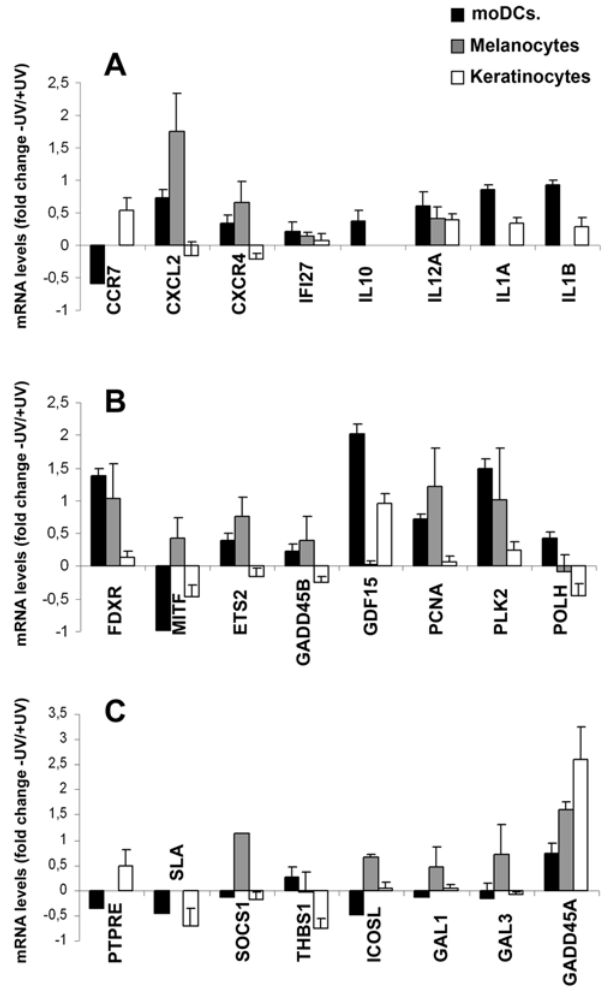
Figure 2. Gene expression induced by UV irradiation in human primary DCs, MCs and KCs. Human primary monocyte-derived DCs (moDCs), melanocytes (MCs) and keratinocytes (KCs) were exposed to solar-simulated UV radiation (3.7 J/cm 2 UVA + 0.3 J/cm 2 UVB) as in Fig. 1 and total RNA was extracted after a further 6 h in culture. Primer sequences are shown in Table S1. Expression levels were normalized to 18s RNA. A . Genes encoding cytokines and chemokine receptors. B . Genes related to DNA damage and p53 response. C . Genes potentially involved in immunomodulation. Results are shown as log10 of fold up- regulation or down-regulation in UV-irradiated cells compared with expression in non-irradiated controls. Data correspond to arithmetic mean 6